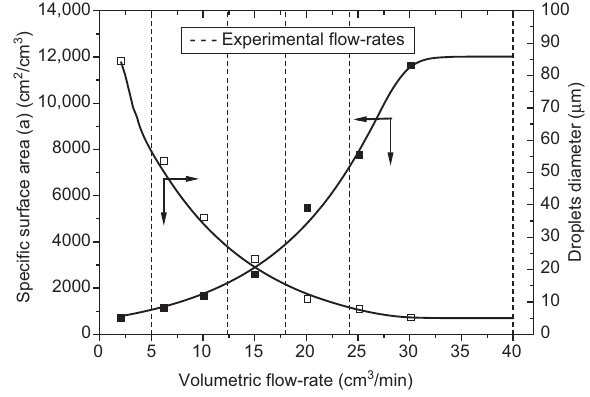
Figure 3 Evolution of the droplets diameters and of the interfacial area as a function of the overall volumetric fl ow rate (data taken from the work of L ö b et al. [16] related to the system water